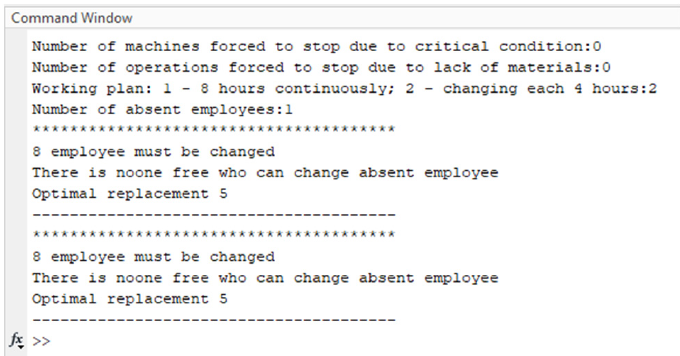
Figure 11. Entered information, 3rd case.